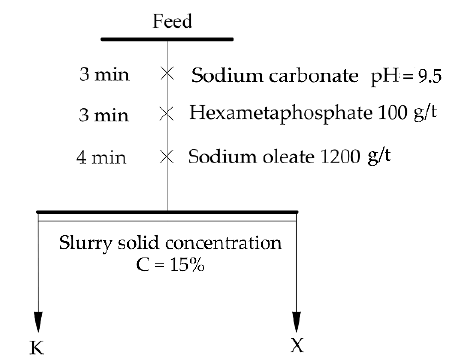
Figure 3. Conditioning procedures used for the flotation tests.